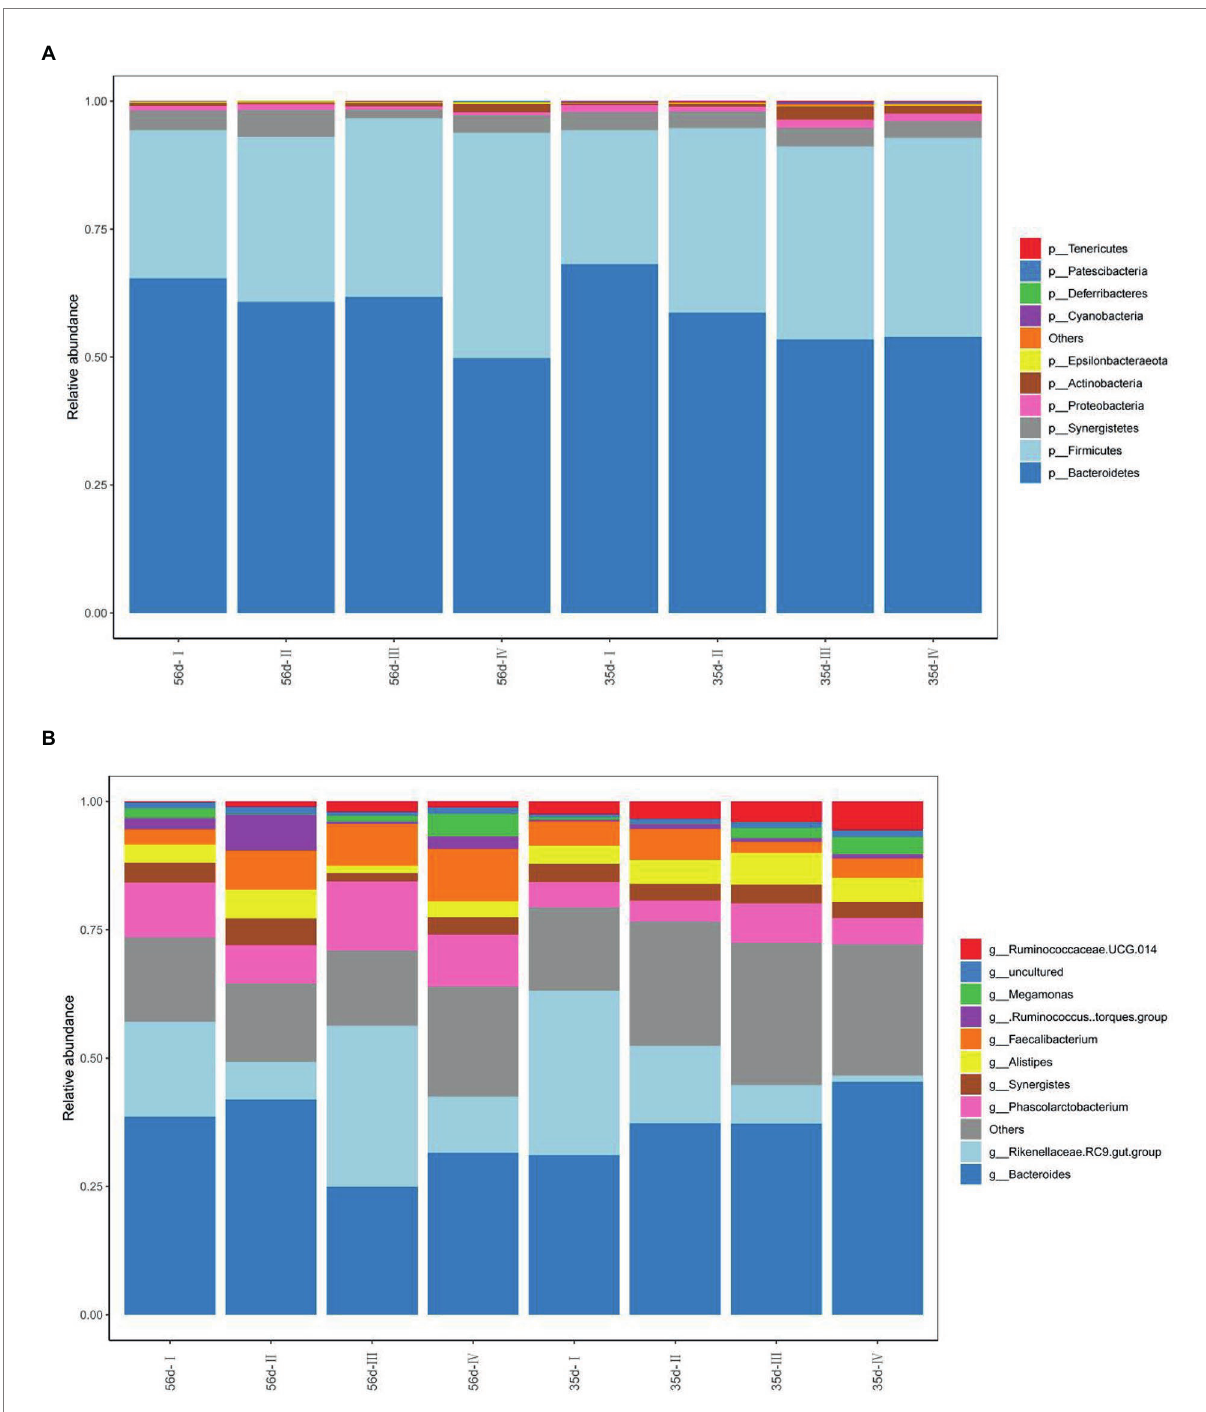
FIGURE 5 The composition of the cecal microflora of broilers in different treatment groups. (A) The phylum level composition of the microflora; (B) The genus level composition of the